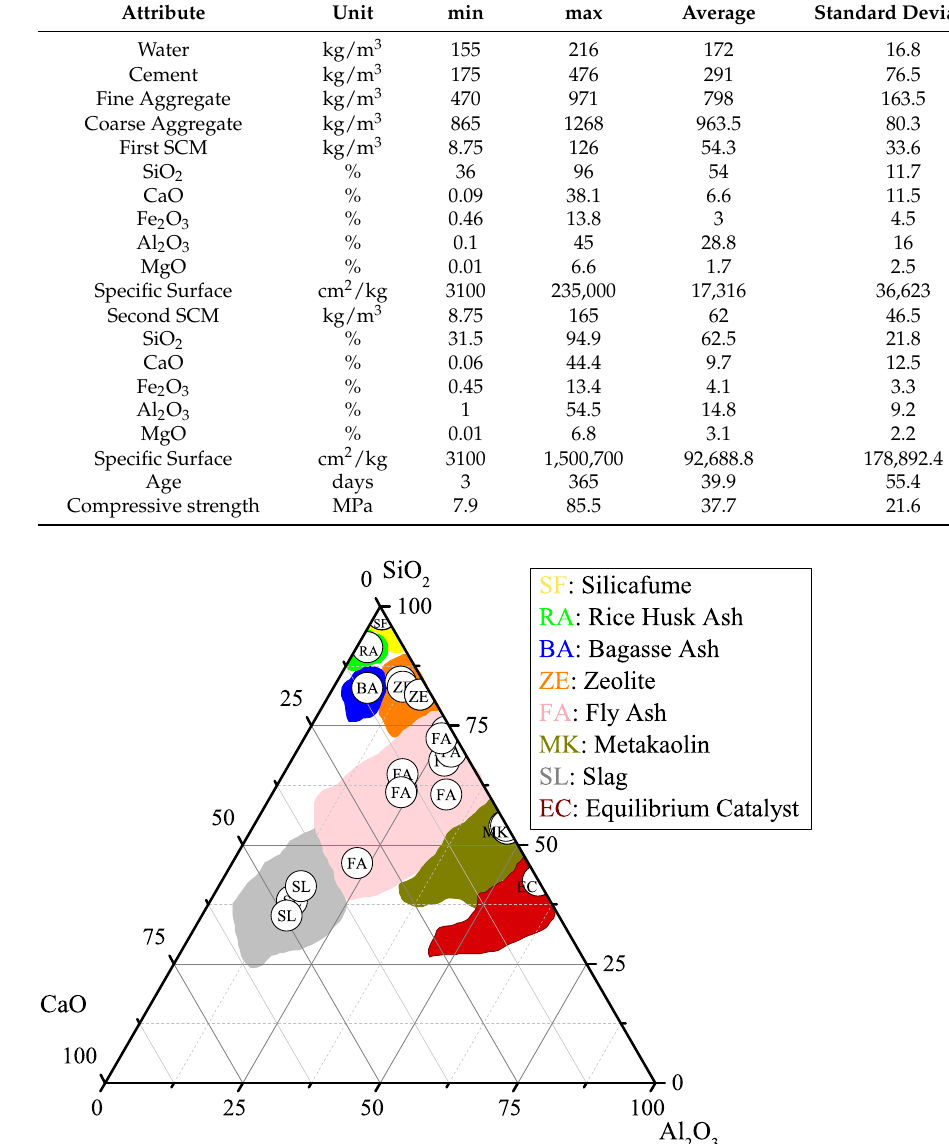
Table 1. Statistical parameters for the concrete containing binary SCMs dataset.